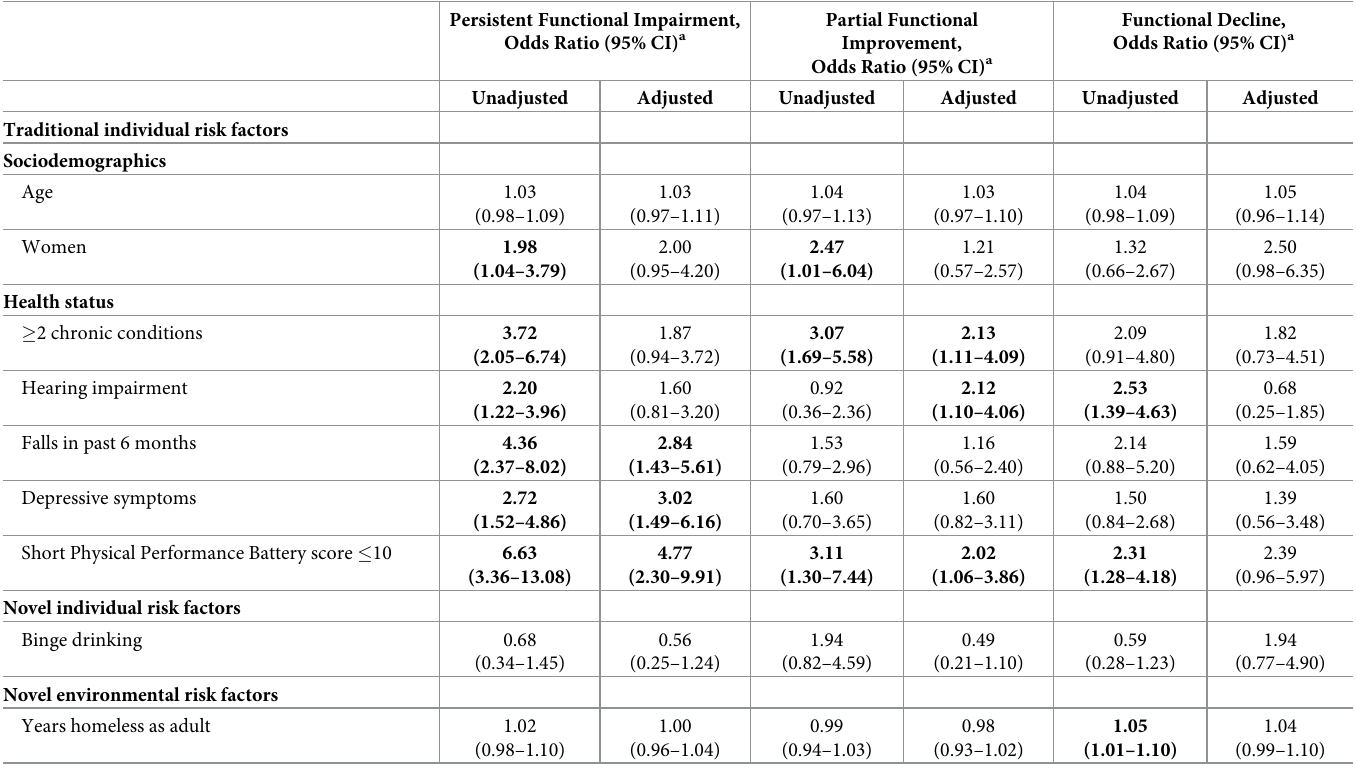
Table 2. Association of baseline characteristics with functional